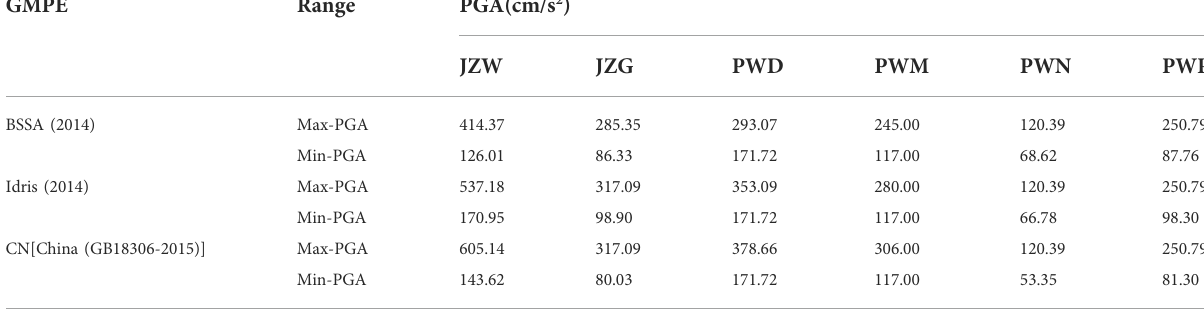
TABLE 5 Peak acceleration range of each typical position obtained after screening the three attenuation relationships. GMPE Range